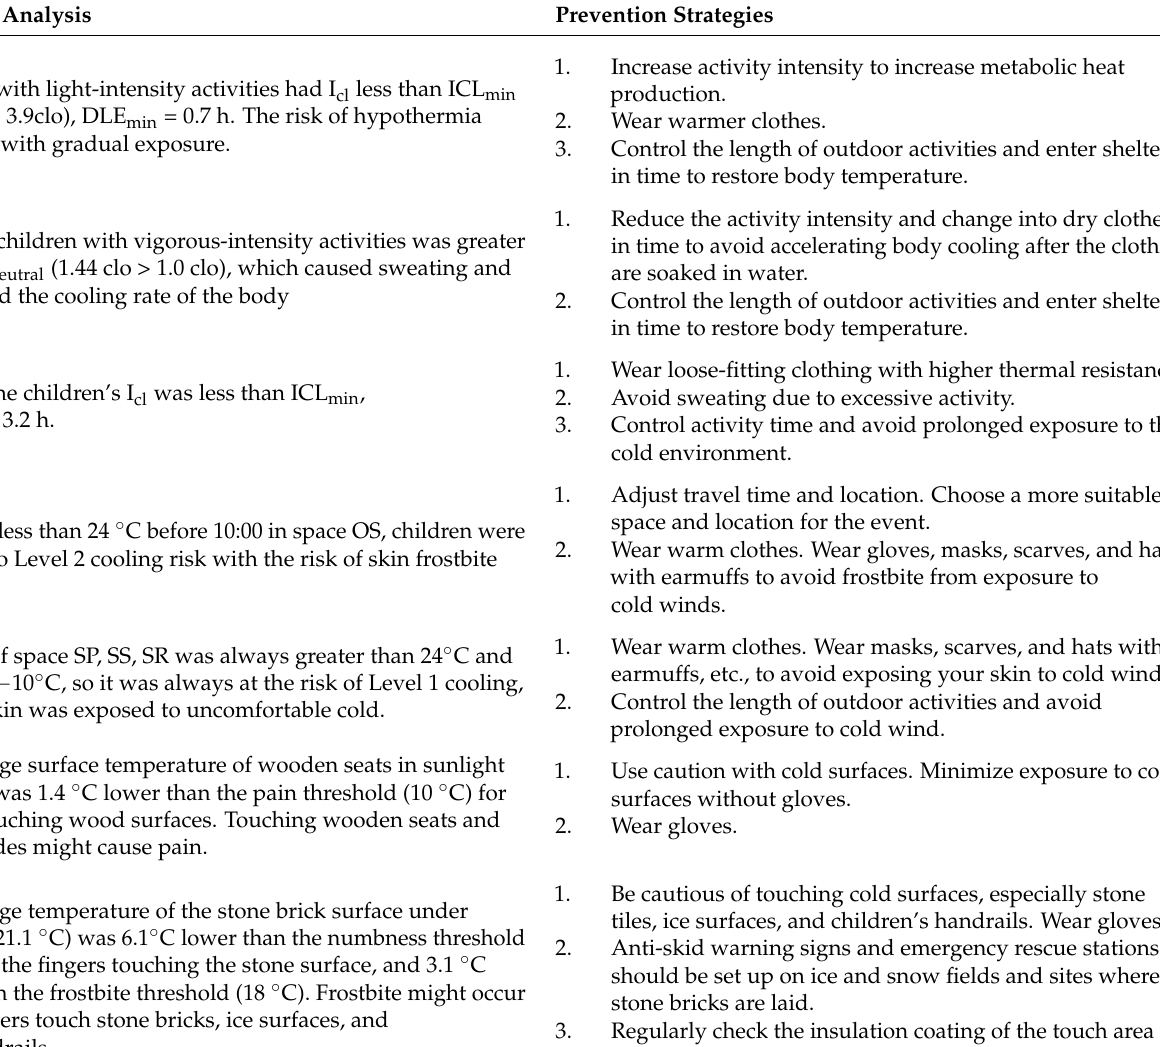
Table 12. Cold risk analysis and corresponding prevention